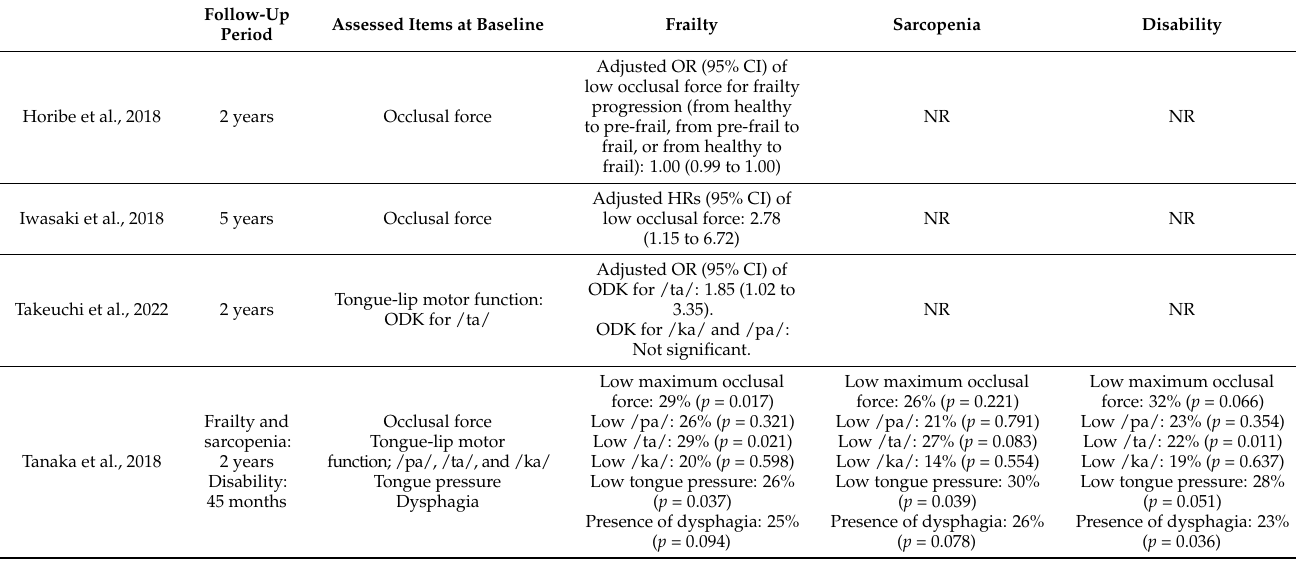
Table 3. Association between oral function and dysphagia at baseline and frailty, sarcopenia, and disability at